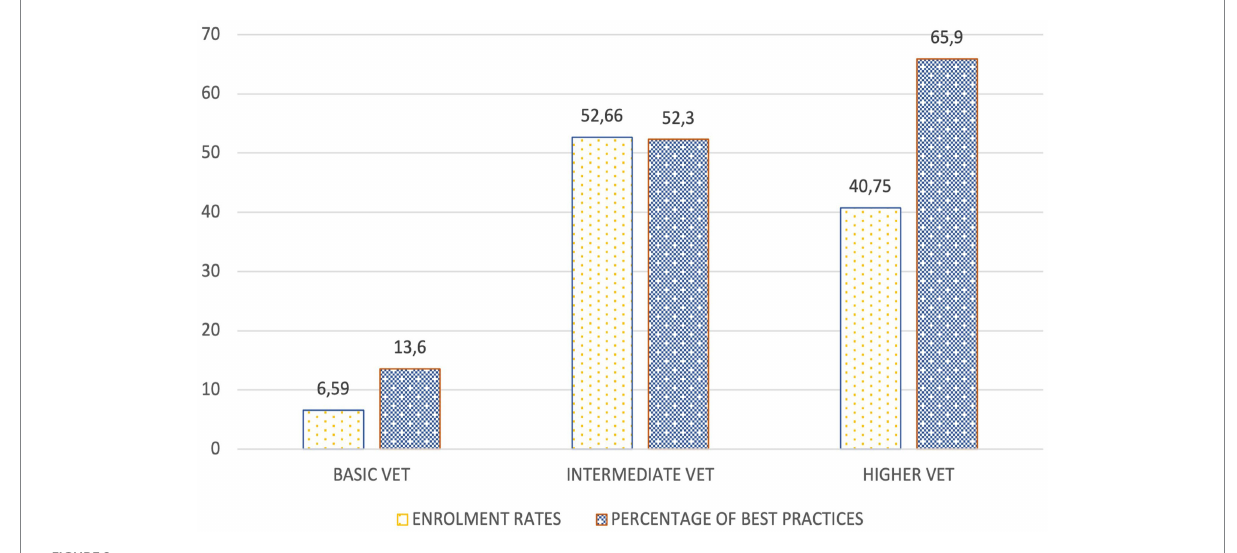
FIGURE 2 Enrolment rates vs. Percentage of best practices.